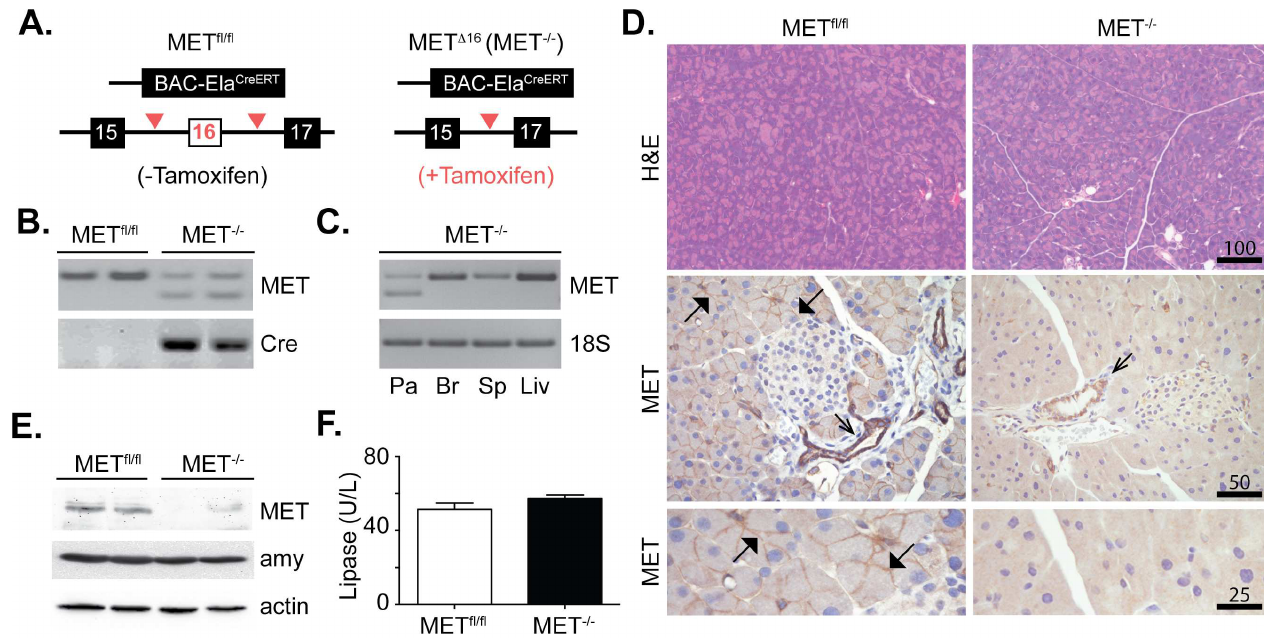
Fig 3. Conditional MET deletion in pancreatic acinar cells. A, Schematic analysisof the MET fl/fl versus MET -/- alleles. B, PCR analysis confirmed MET knockout, in Cre-expressing MET -/- mice but not MET fl/fl mice. C, PCR analysisconfirmed pancreatic (Pa) MET knockout, but not in Brain (Br), Spleen (Sp) or Liver (Liv). 18S RNA served as a loadingcontrol. D, Representative H&E and MET staining in ducts and acinar membranesis shown (open and closed arrowheads respectively) (Scale, microns). E, Western analysis confirmed reduced MET protein expression in MET -/- mice. Amylase (amy) and actin were unaffected. F, Serum lipase levels were unaffected in MET fl/fl and MET -/- mice. Data collectedfrom 4–5 mice/